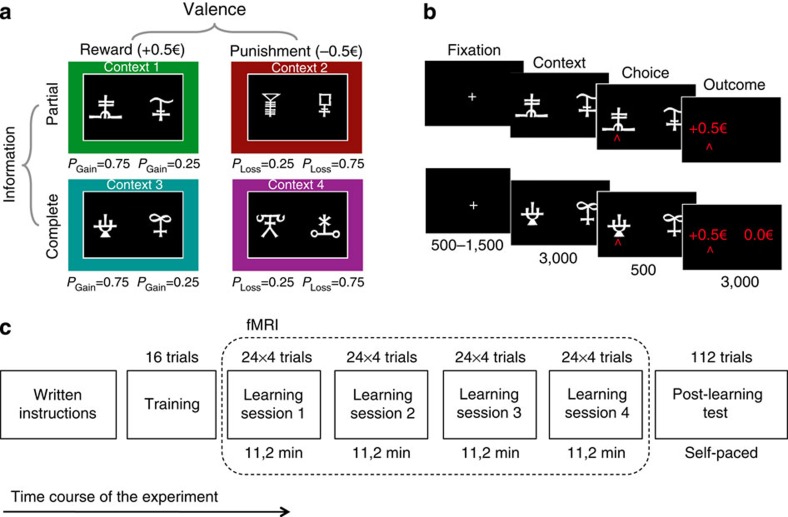
Experimental task and design.(a) Learning task 2 × 2 factorial design with 4 different contexts: reward/partial, punishment/partial, reward/complete, and punishment/complete. PGain= probability of winning 0.5€; PLoss= probability of losing 0.5€. Note that the coloured frames are introduced in the figure for illustrative purposes, but were not present in the original task. (b) Successive screens of typical trials in the reward partial (top) and complete (bottom) contexts. Durations are given in milliseconds. (c) Time course of the experiment. Note that the post-learning test was uniquely based on the eight options of the last learning session.